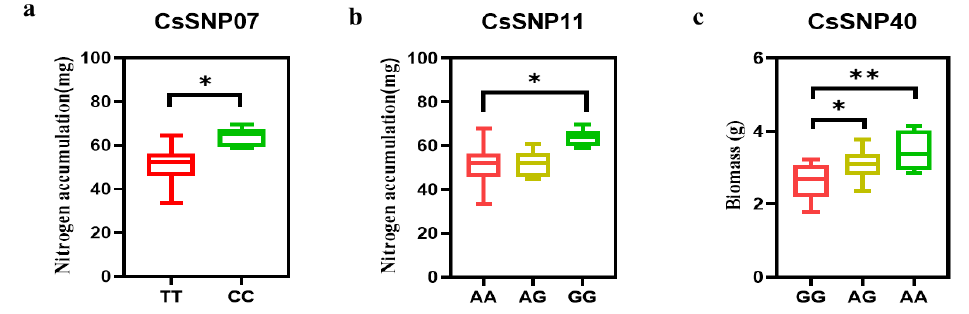
Figure 7. Phenotypic comparison of different genotypes. ( a ) Nitrogen accumulation of different genotypes in CsSNP07, ( b ) nitrogen accumulation of different genotypes in CsSNP11, ( c ) biomass of different genotypes in CsSNP40. * indicate significant differences ( p < 0.05), ** indicate significant differences ( p < 0.01).